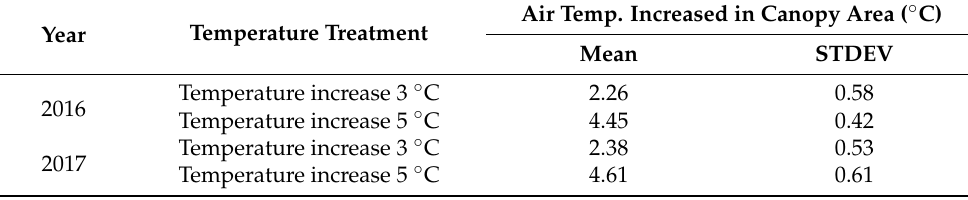
Table 2. Temperature increase in the grain filling stage compared to